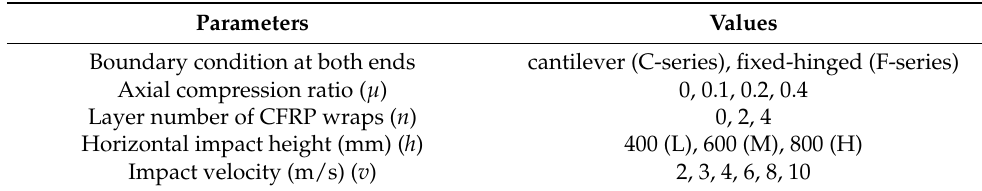
Table 3. Parametric values.